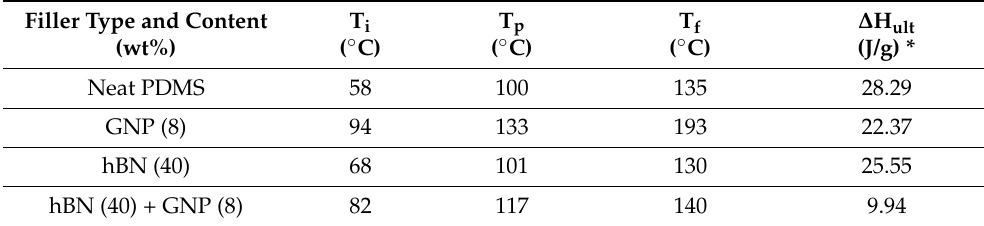
Table 3. DSC scan results for neat PDMS and PDMS-based nanocomposites containing different amounts of GNPs and hBN at 10 ◦ C/min heating